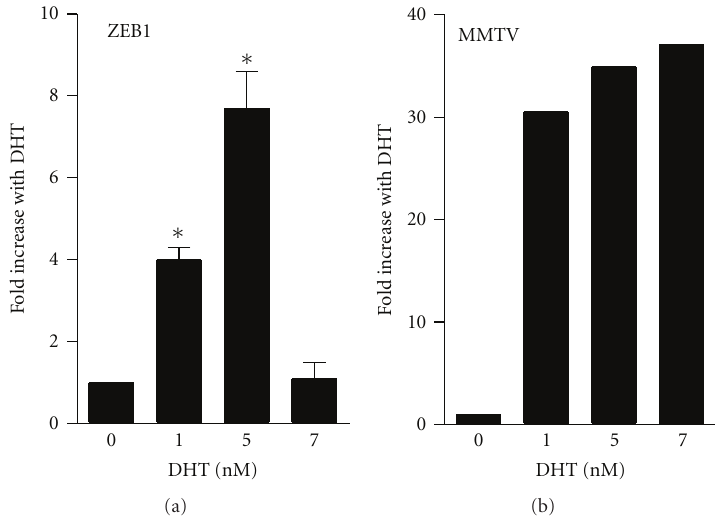
Figure 3: DHT induces tcf8 at the transcriptional level . PC-3/AR cells were transiently transfected with a β -galactosidase reporter plasmid (pBlueZEB974) containing sequences − 982 to − 9 from tcf8 (left panel) or the MMTV promoter (right panel) and increasing concentrations of DHT as indicated. β -galactosidase activity was determined, and the results are plotted relative to values in the absence of DHT. n = 3, ∗ P < 0 . 5 compared to no